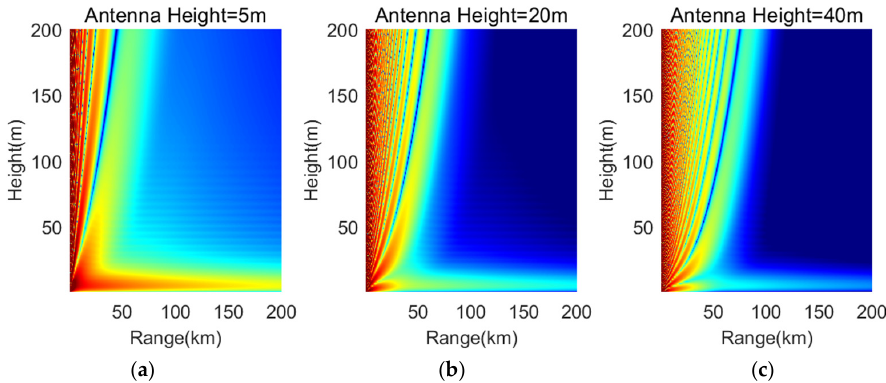
Figure 17. Path loss distributions for evaporation ducts with di ff erent antenna heights: ( a ) antenna height of 1 m, ( b ) antenna height of 20 m, and ( c ) antenna height of 40 m.